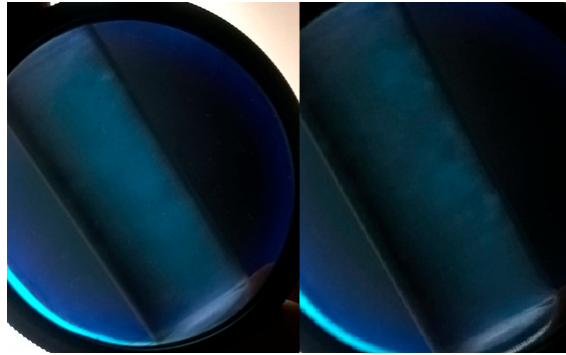
Table 4. Yield and concentration of cellulose pulp and nanocrystals in the different lignocellulosic sources.